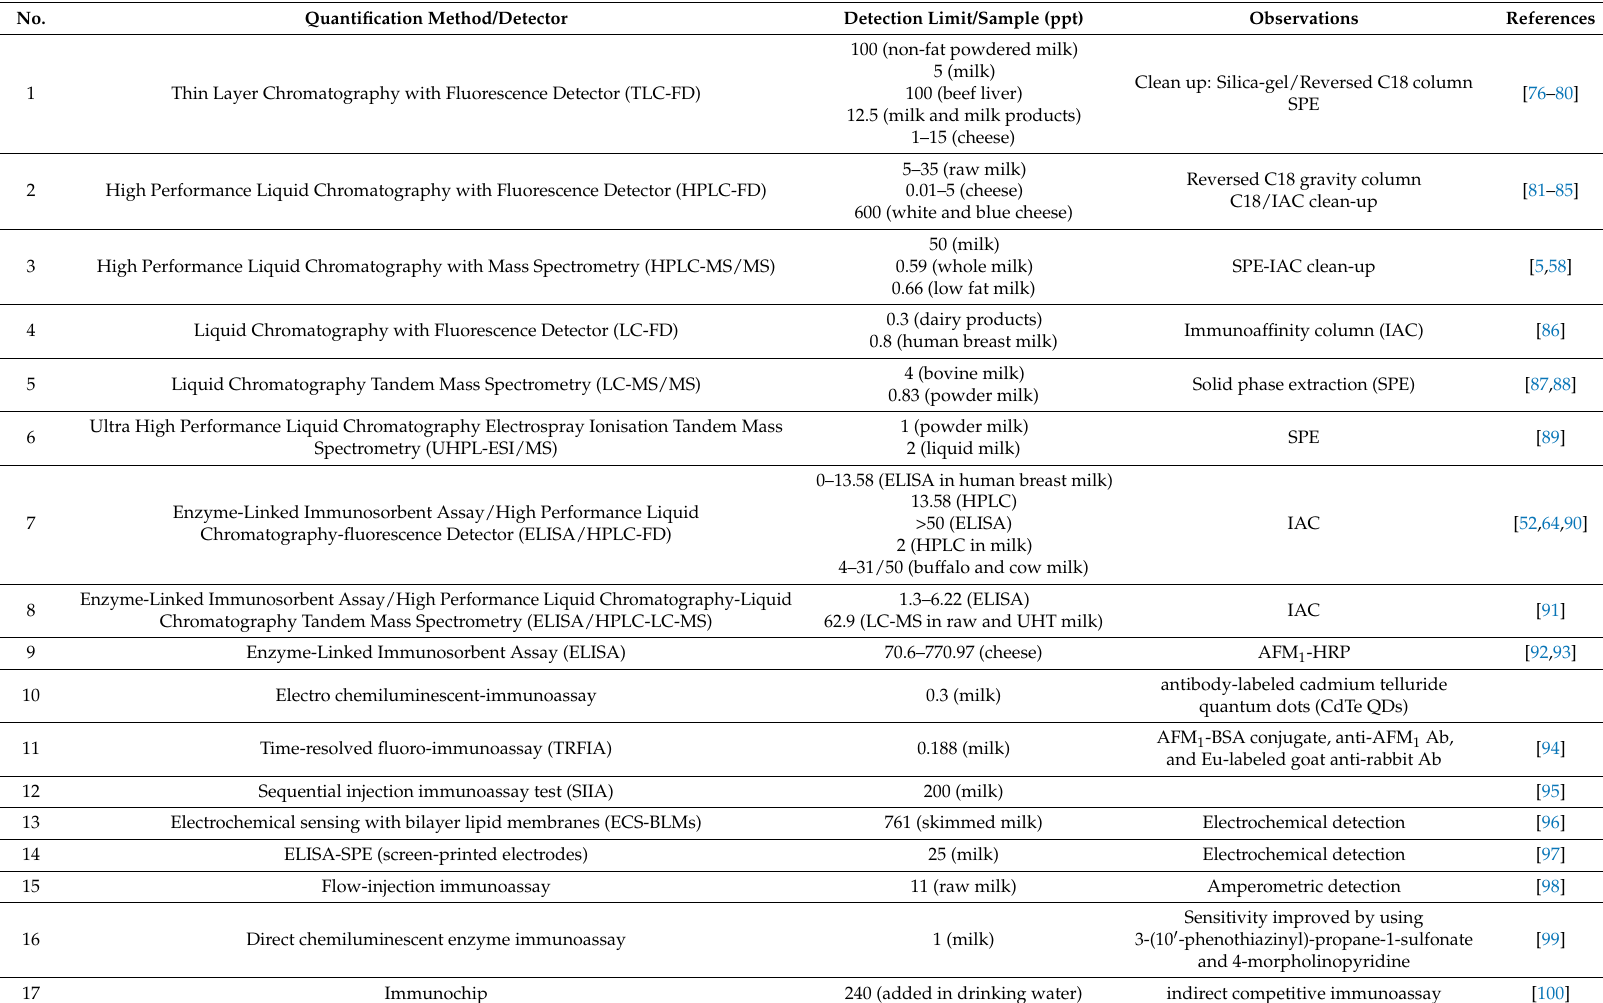
Table 3. Aflatoxin M 1 quantification by chromatographic